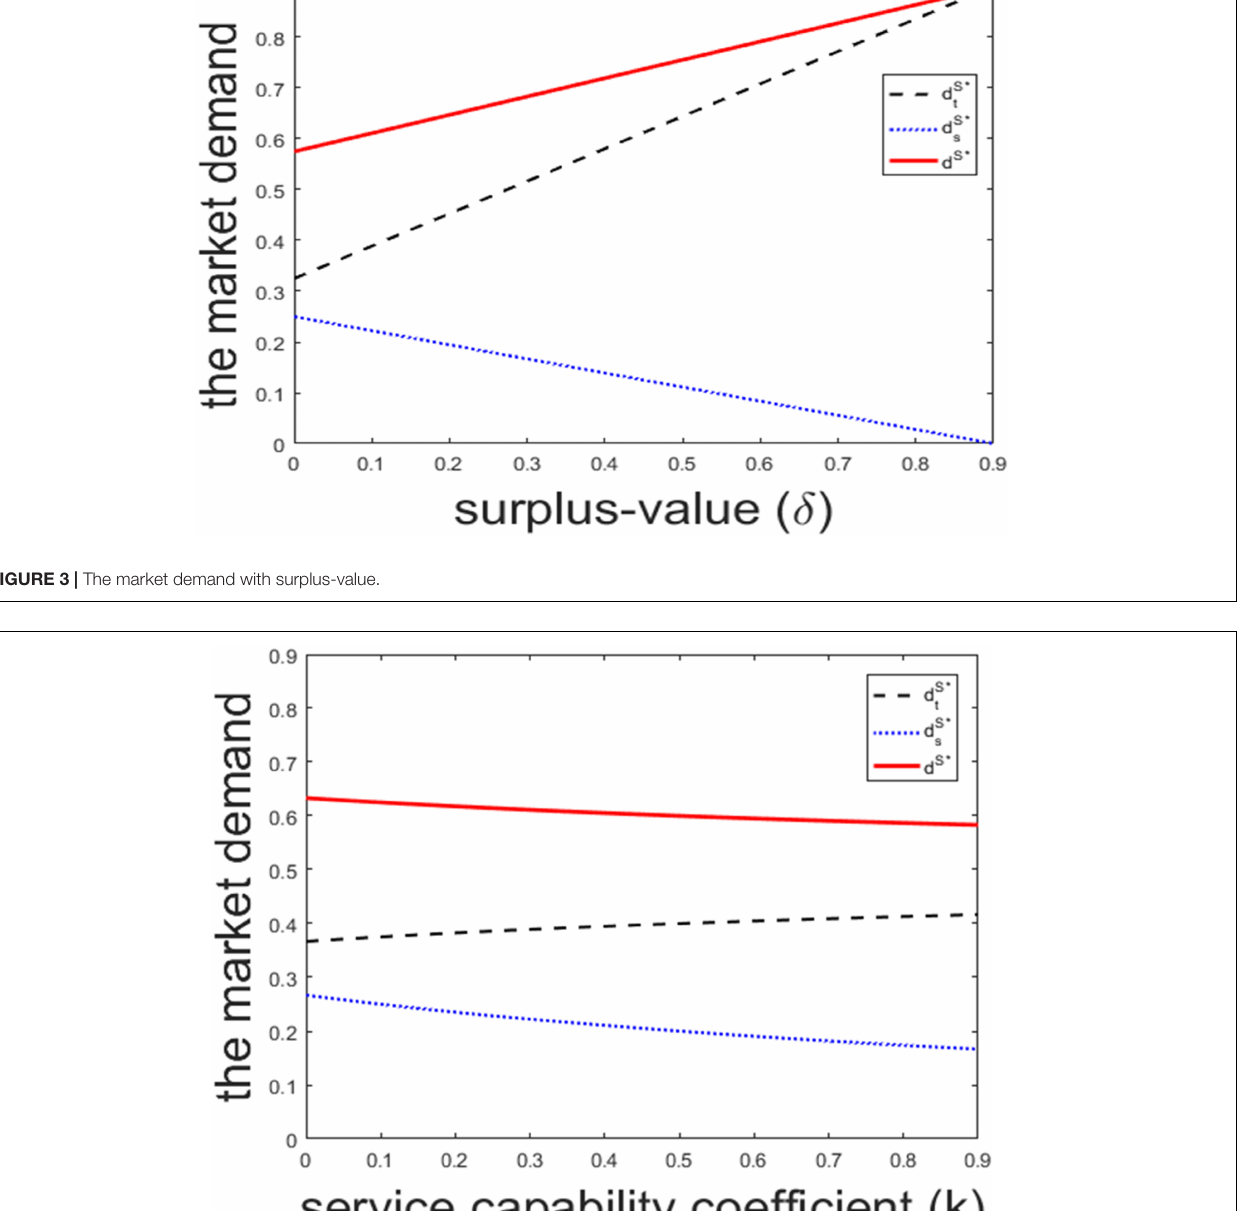
FIGURE 4 | The market demand with service capability